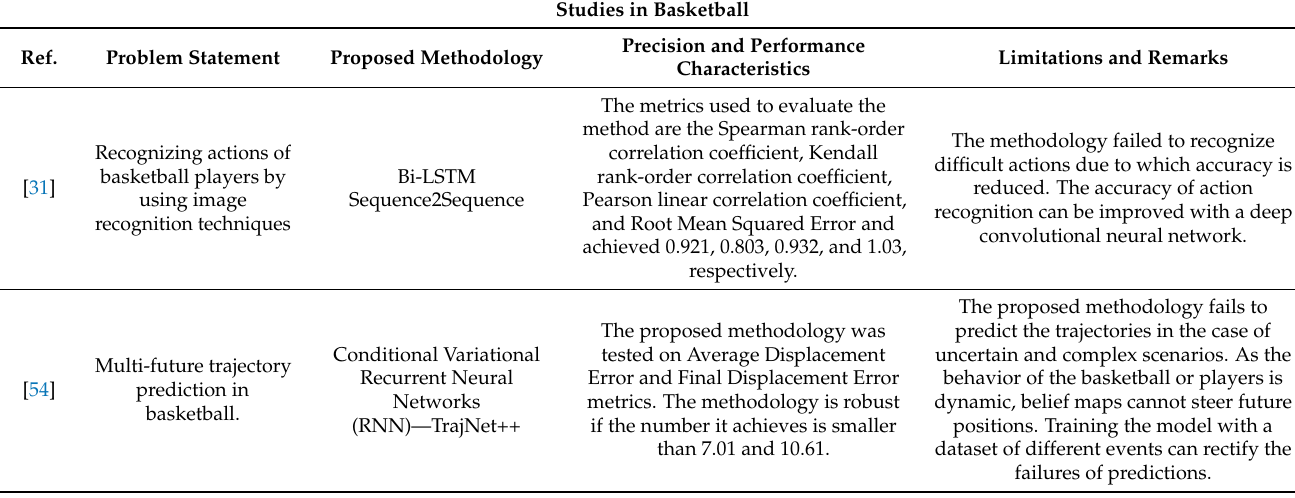
Table 2. Studies in